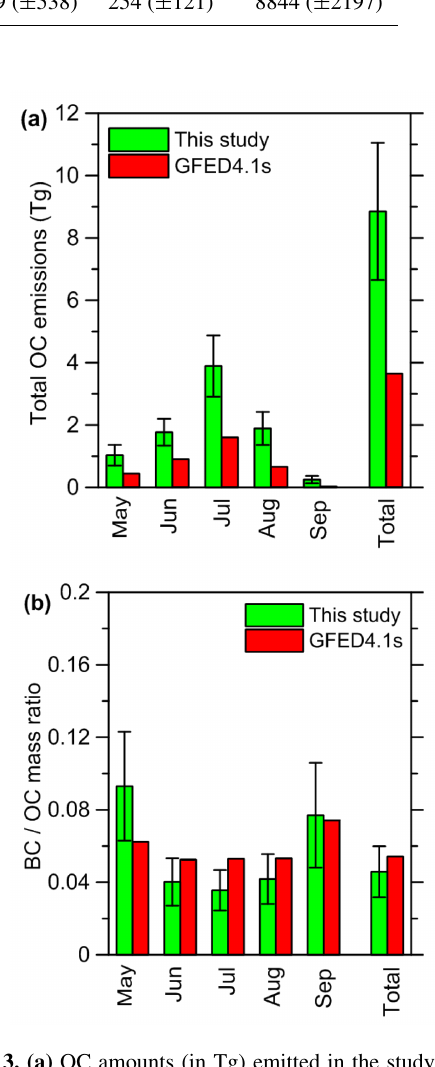
Figure 13. (a) OC amounts (in Tg) emitted in the study region in period from May to September 2012 according to this study and the GFED4.1s data along with (b) the corresponding estimates of the BC / OC emission ratios (gg − 1